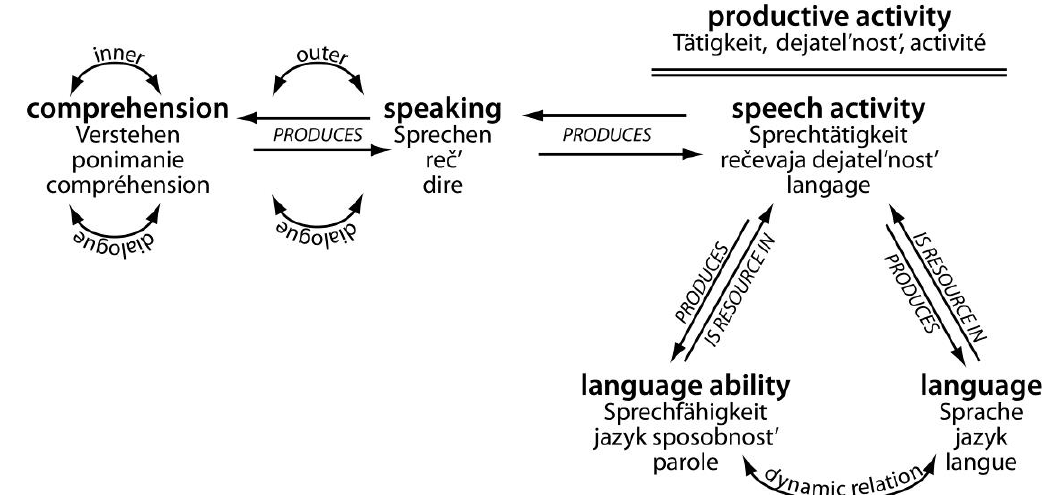
Figure 1. Model of the relation between the different components in speaking and language.